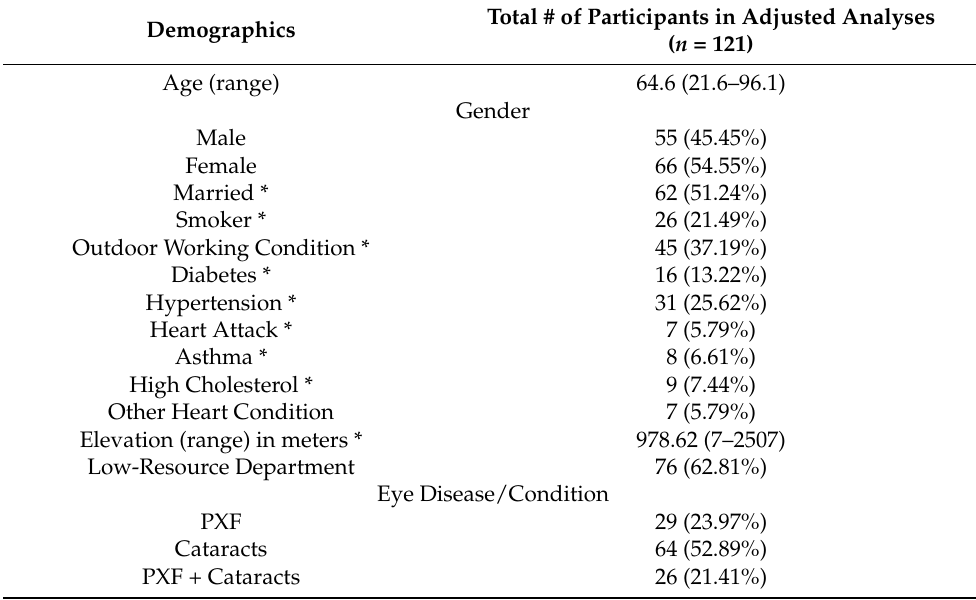
Table 3. Demographic table for participants used in univariate and multivariate analyses.